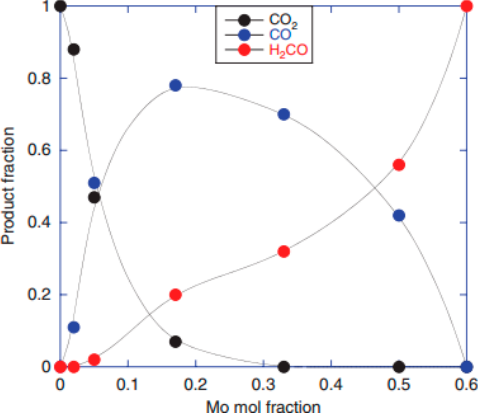
Figure 19. The yields of the three main products of methanol oxidation seen in TPD, as a function of the amount of Mo in the catalyst. A mole fraction of 0.6 corresponds with the stoichiometric materials Fe 2 (MoO 4 ) 3 . Image adapted from Catal. Struct. React. , 2015 , 1 , 95–100 [36].